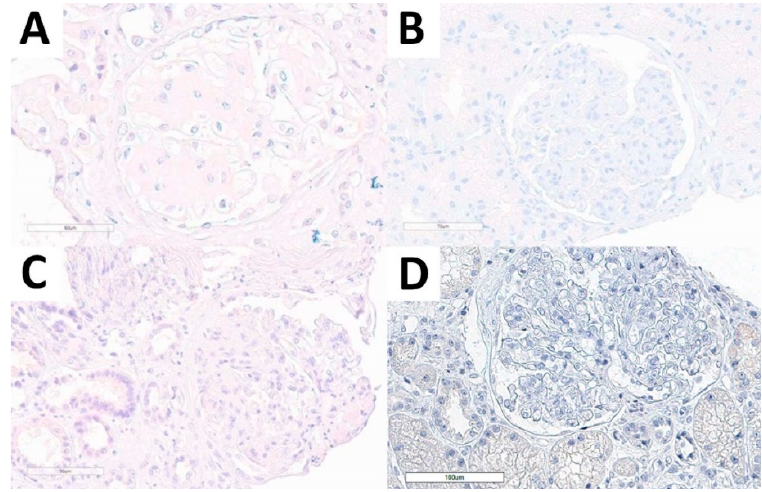
Figure 4. DNAJB9 IHC stain in the non-FGN cohort. DNAJB9-negative stain in amyloidosis ( A ), immunotactoid glomerulopathy ( B ), idiopathic nodular glomerulosclerosis ( C ), and PGNMID ( D ) cases.